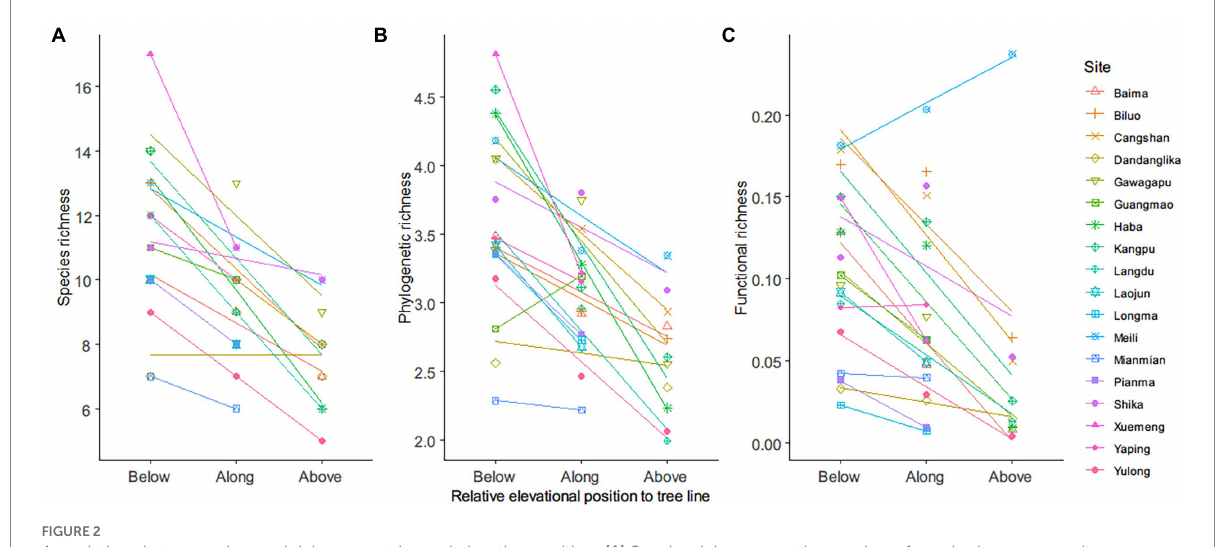
FIGURE 2 Associations between observed richness metrics and elevation position. (A) Species richness was the number of species in a community. (B) Phylogenetic richness was measured as the sum of the branch length of a phylogenetic tree. (C) Functional richness was measured as the minimum convex hull volume. The point symbols with different shapes and colors mark the observed richness values in different sites (18 sites). The solid lines show the linear regression relationships between the richness values and elevation